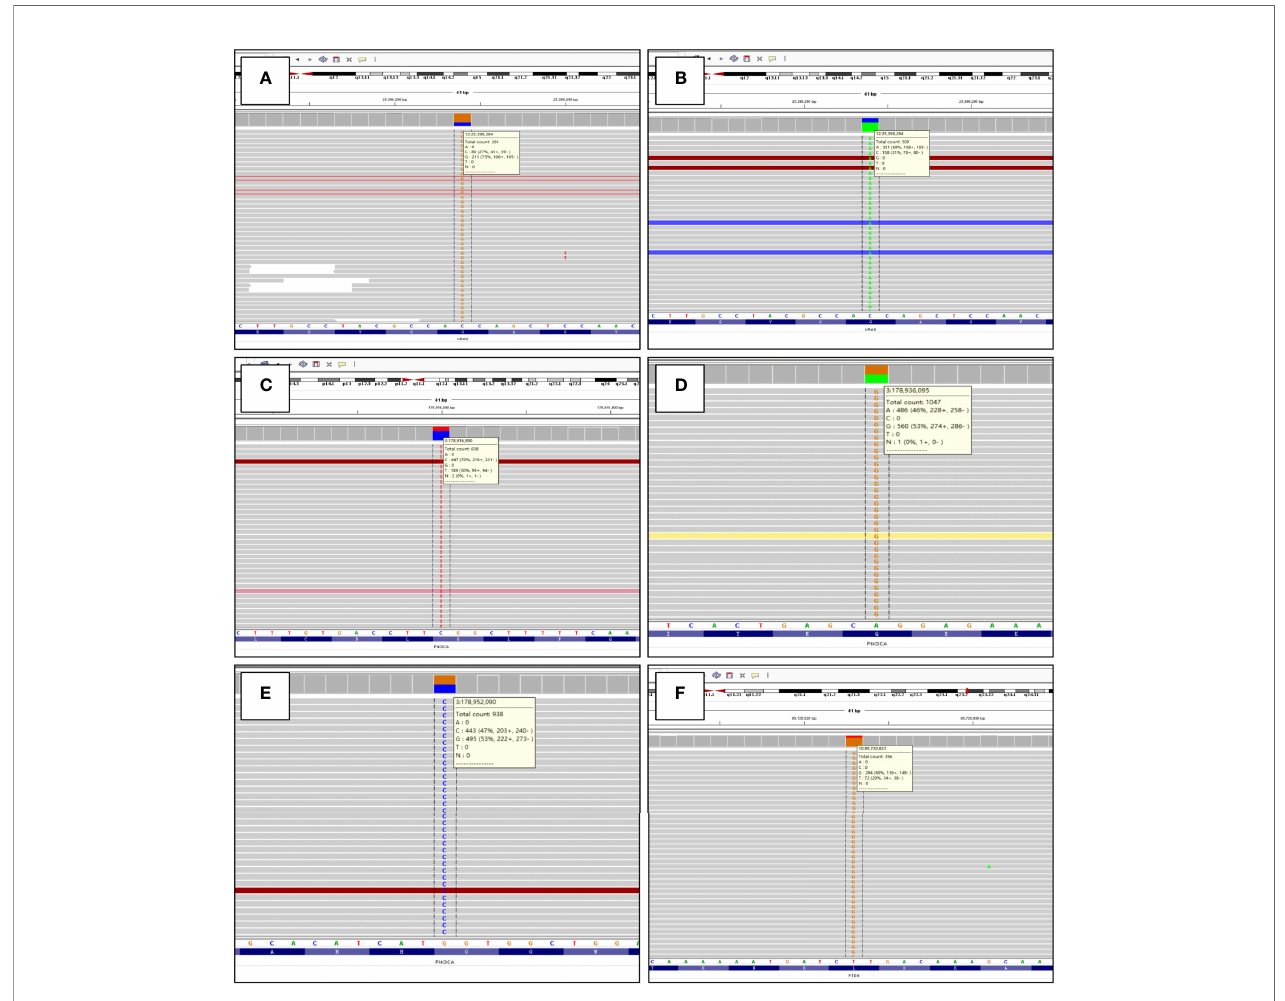
FIGURE 7 | Molecular genetic fi ndings of uterine corpus MLA detected by targeted next-generation sequencing, as shown by the Integrative Genomics Viewer screenshot. (A) KRAS exon2: c.35G>C (p.G12A) (case 1). (B) KRAS exon2: c.35G>T (p.G12V) (case 2). (C) PIK3CA exon1: c.277C>T (p.R93W) (case 2). (D) PIK3CA exon9: c.1637A>G (p.Q546R) (case 3). (E) PIK3CA exon20: c.3145G>C (p.G1049R) (case 4). (F) PTEN exon8: c.974T>G (p.L325R) (case 1).